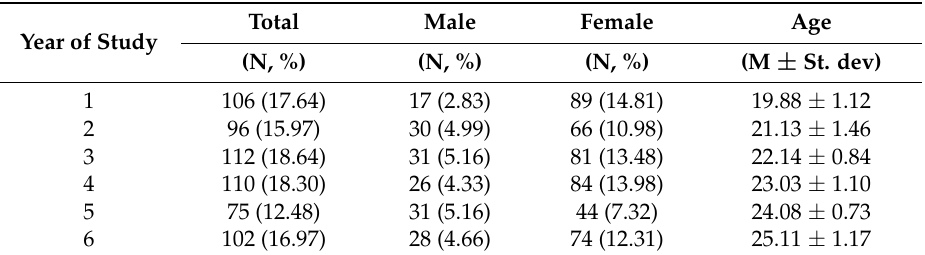
Table 1. The distribution of students accordingly to the year of study and sex.